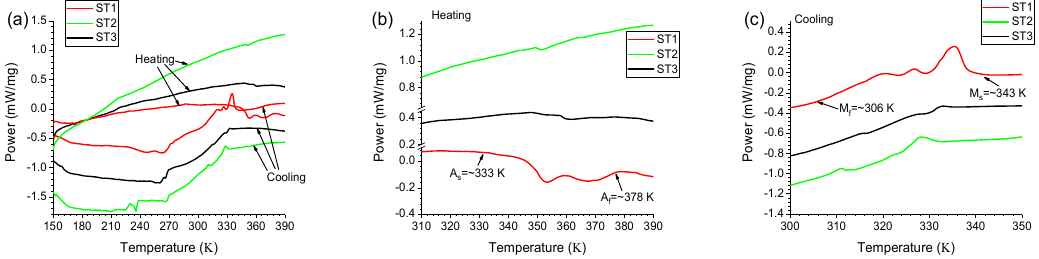
Figure 3. Results of differential scanning calorimetry measurements on the Ni-Ti alloy micro-foils ( a ) in the whole temperature range, ( b ) during heating, and ( c ) cooling. Transition temperatures are respectively marked.